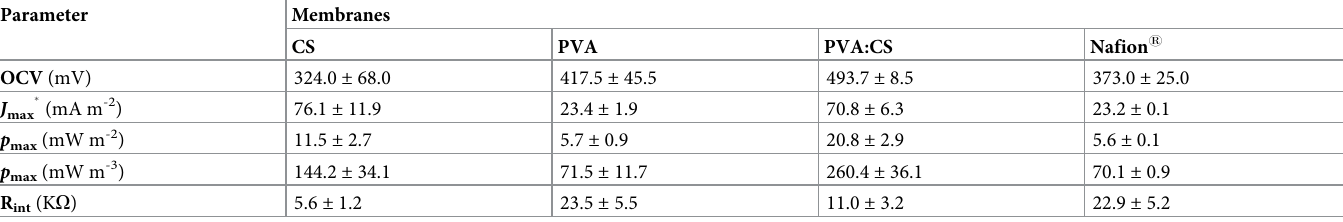
Table 2. Relevant characteristic of different membranes assayed in an H-type MFC set-up.